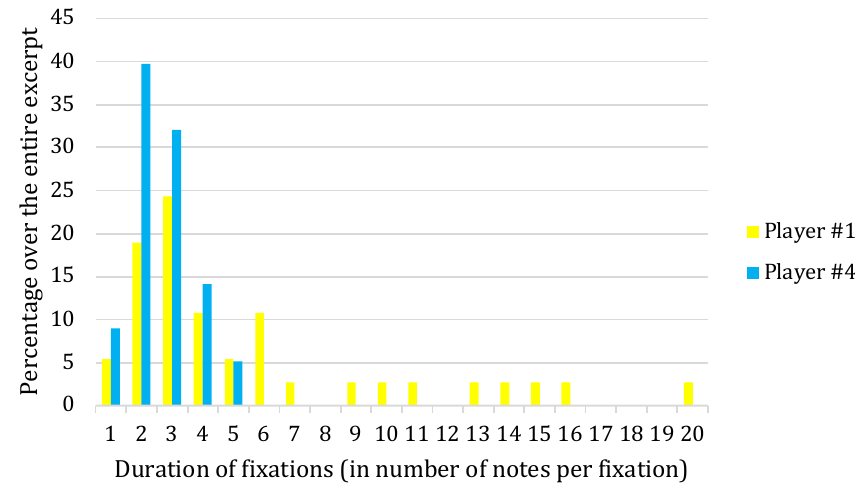
Figure 11. Comparison of Fixation-Duration (in % of total number of fixations over the total excerpt) for Player #1 and #4 at 127bpm for the musical excerpt of ‘Porgy and Bess’.